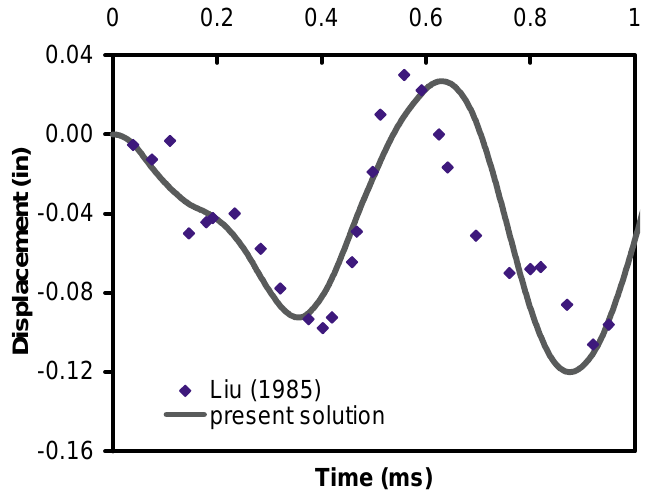
Fig. 6. Vertical displacement at centre of spherical cap – Von Mises material.